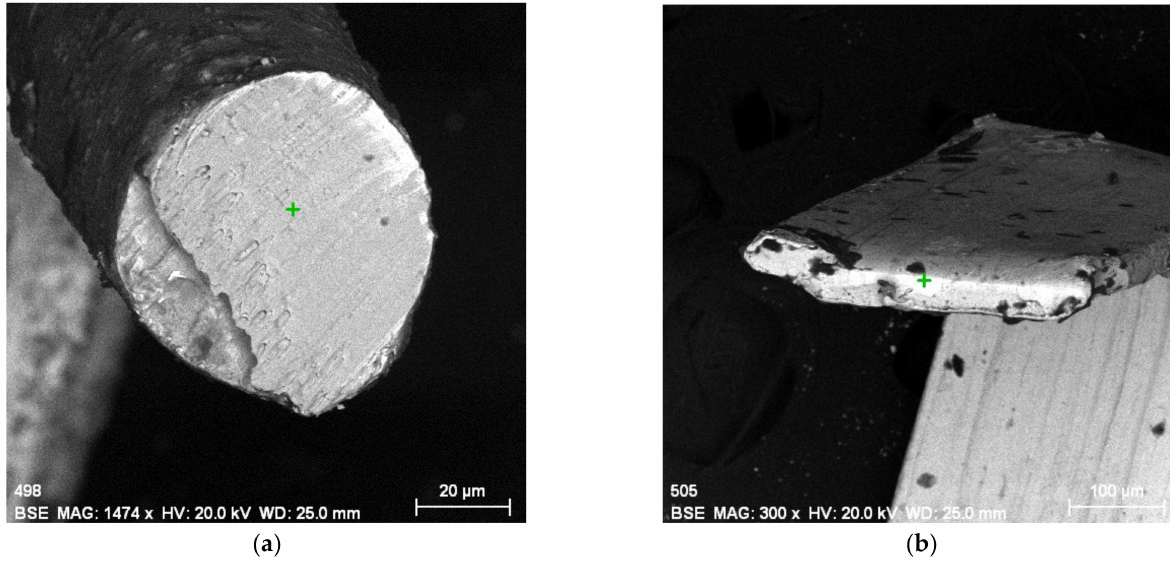
Figure 4. SEM-EDX pictures of cross-sections: ( a ) silver-plated wire from Split folk costume; ( b ) gilded narrow stripe from Zagreb Cathedral liturgical